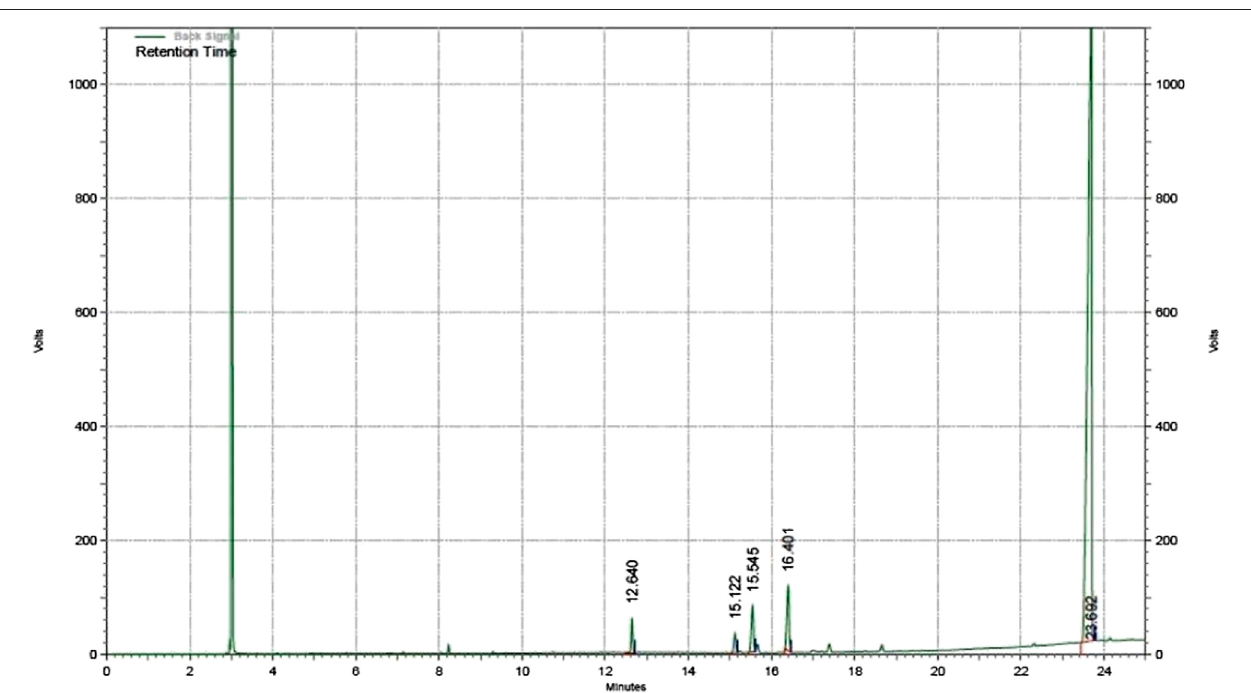
FIGURE 6 | Surface plots of interactive impacts on biodiesel yield (A) reaction temperature and catalyst concentration (B) reaction temperature and methanol concentration (C) reaction temperature and agitation speed (D) catalyst concentration and methanol concentration (E) catalyst concentration and agitation speed (F) methanol concentration and agitation